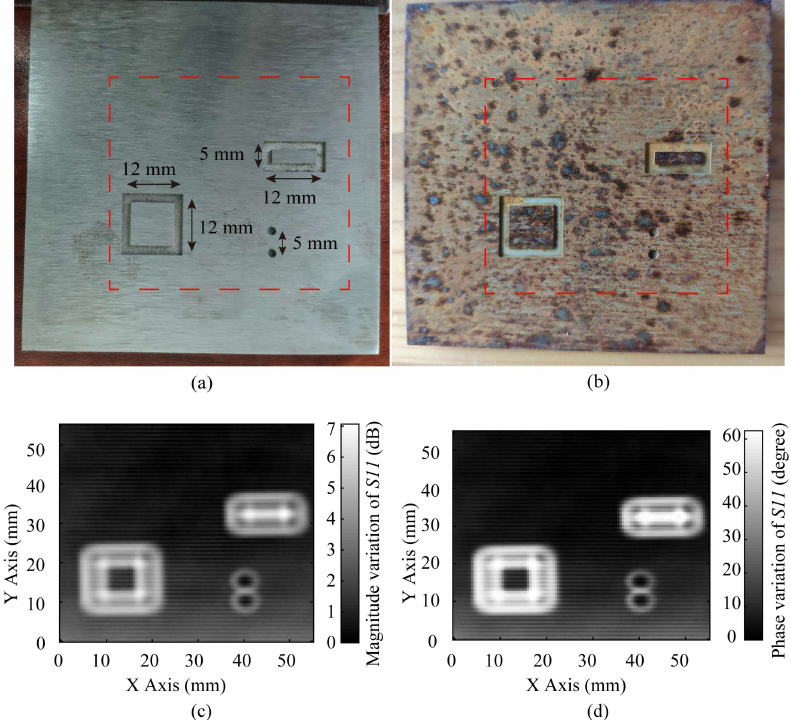
Figure 17. ( a ) The unrusted carbon steel board with patterns etched; ( b ) The rusted carbon steel board with patterns etched; ( c ) The image of the rusted carbon steel acquired by the variation of S11 magnitude; ( d ) The image of the rusted carbon steel acquired by the variation of S11